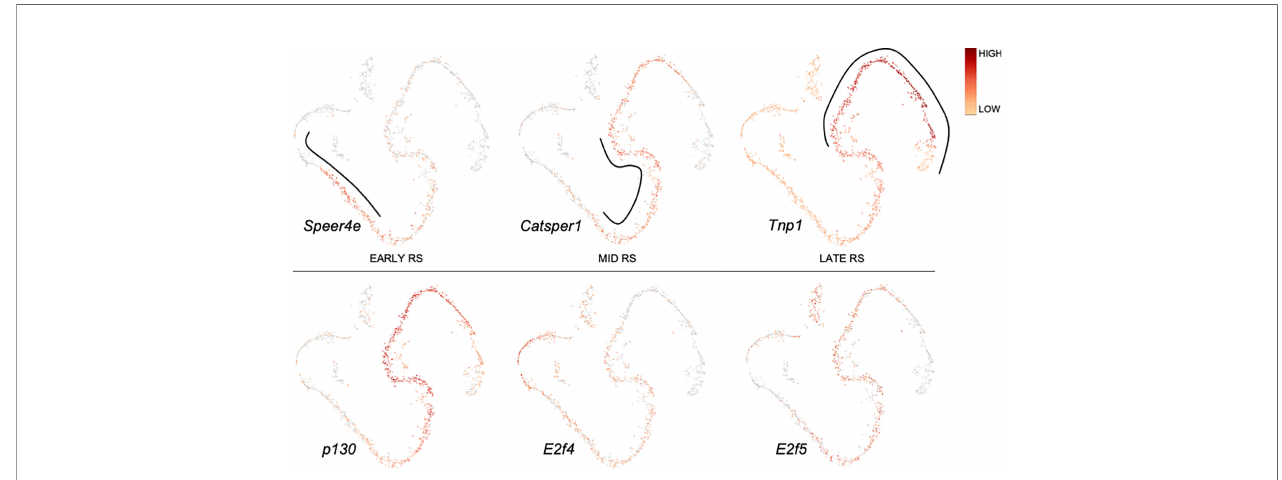
FIGURE 4 | Expression of p130, E2f4 and E2f5 along a pseudotime trajectory of sorted mouse round spermatids. The data is extracted from Hermann et al. 2018 (26) using Loupe Cell Browser v6.0.0 from 10x Genomics. Expression for Speer4e, Catsper1 and Tnp1 are included to demarcate early, mid and late round spermatids,